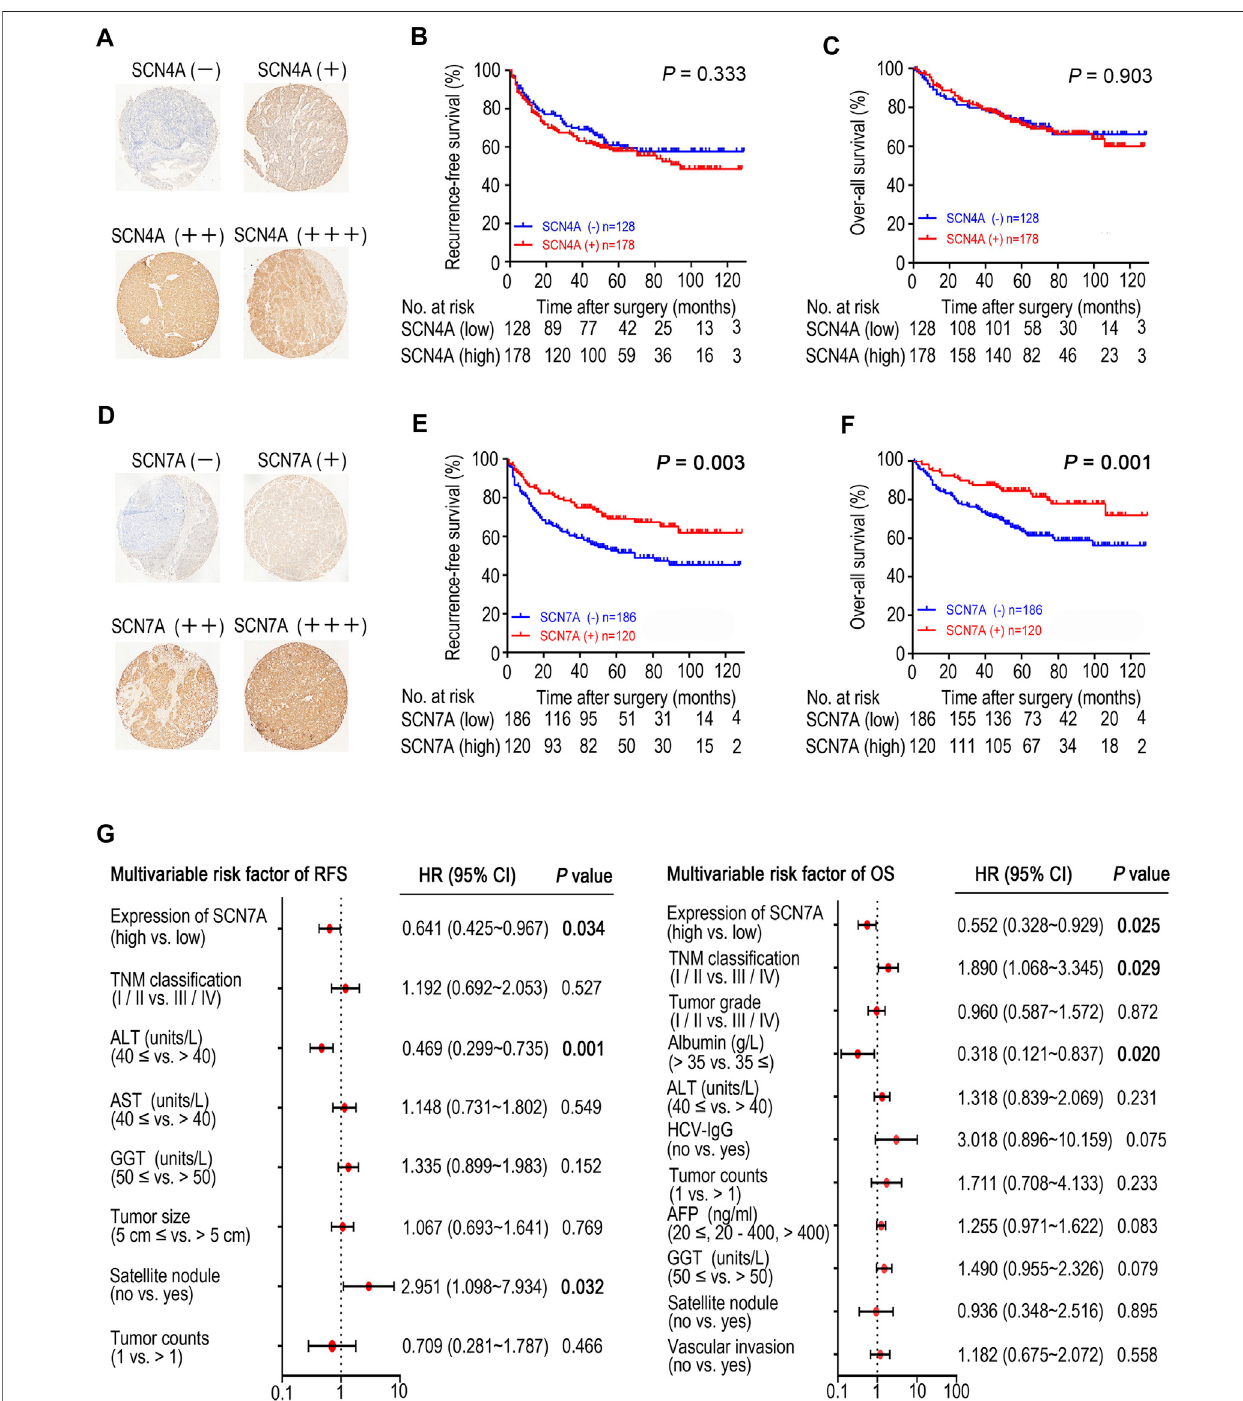
FIGURE 5 | The expression of SCN4A/7A protein in HCC by immunohistochemistry and the survival analysis of patients with SCN4A/7A protein expression. (A) SCN4A protein staining in HCC. (B) SCN4A protein expression was not related to RFS ( p > 0.05). (C) SCN4A protein expression was not related to OS ( p > 0.05). (D) SCN7A proteinstaininginHCC. (E) Higherexpressionof SCN7A proteinwasrelatedtolongerRFStime( p (cid:1) 0.003). (F) Higherexpressionof SCN7A proteinwasrelated to longer OS time ( p (cid:1) 0.001). (G) Cox multivariate analysis of contributory factors to recurrence-free survival and overall survival.